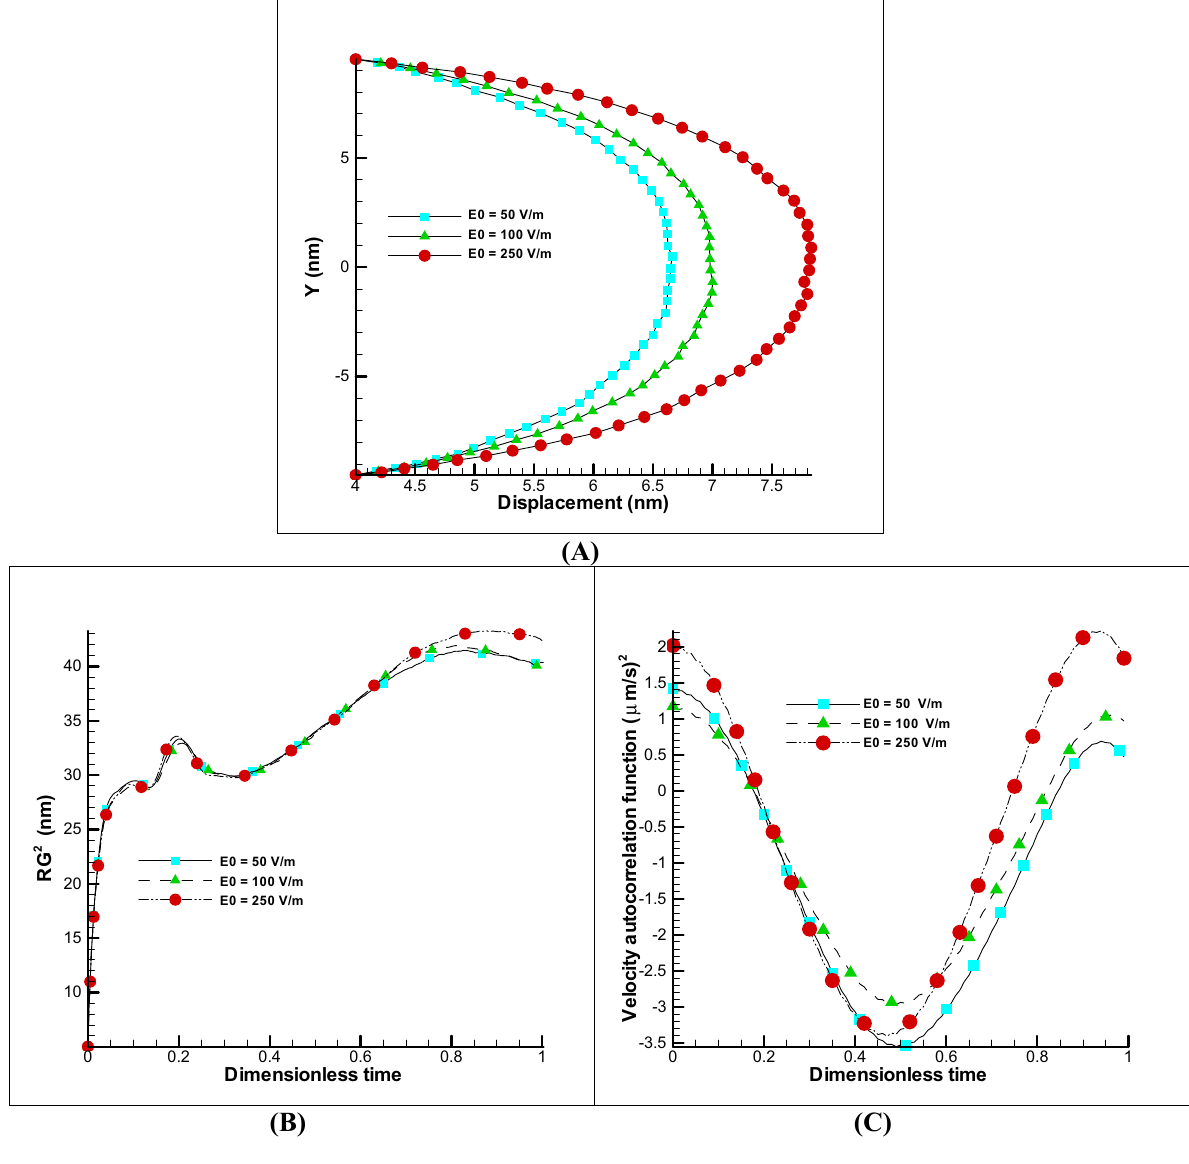
Figure 6. Changes of electric field on EOF and polymer membrane. Different displacement of polymer membrane by changing the electric field, kH = 8, Ψ 0 = − 25 mV ( A ). Variation of radius of gyration and VACF over dimensionless time (t/t max ) by changing the electric field ( B , C